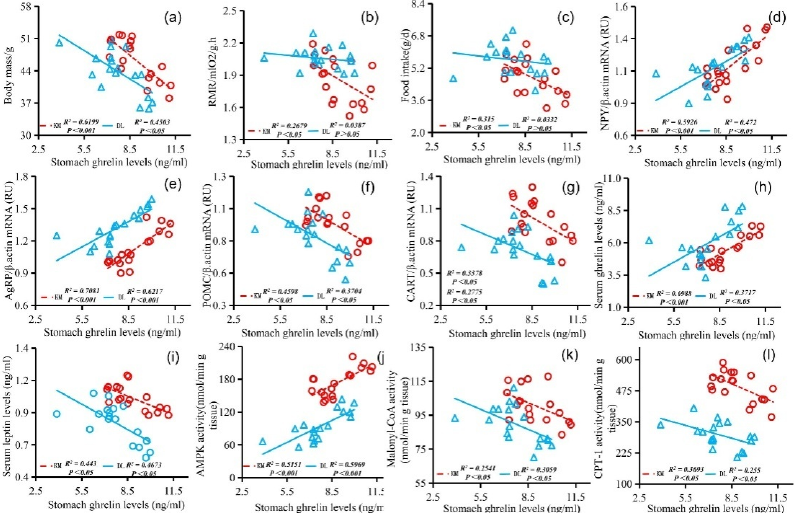
Figure 5. Correlation diagram between stomach ghrelin concentration and body mass ( a ), RMR ( b ), food intake ( c ), NPY gene expression ( d ), AgRP gene expression ( e ), POMC gene expression ( f ), CART gene expression ( g ), serum ghrelin concentration ( h ), serum leptin concentration ( i ), AMPK activity ( j ), malonyl CoA activity ( k ), and CPT-1 activity ( l ) in E. miletus under food restriction.